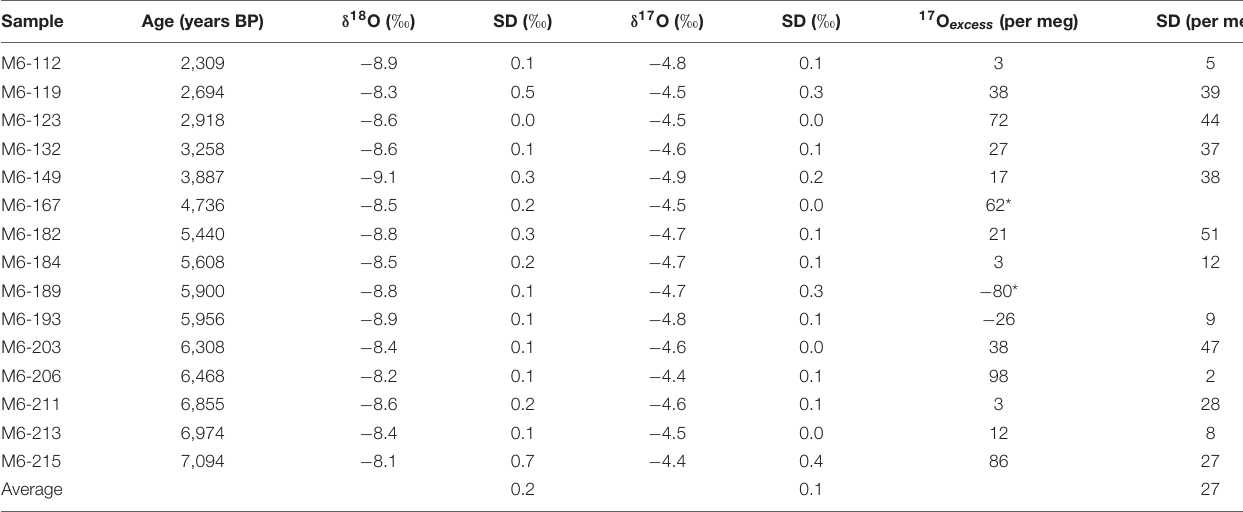
TABLE 3 | Mean values and standard deviations obtained from duplication of stalagmite